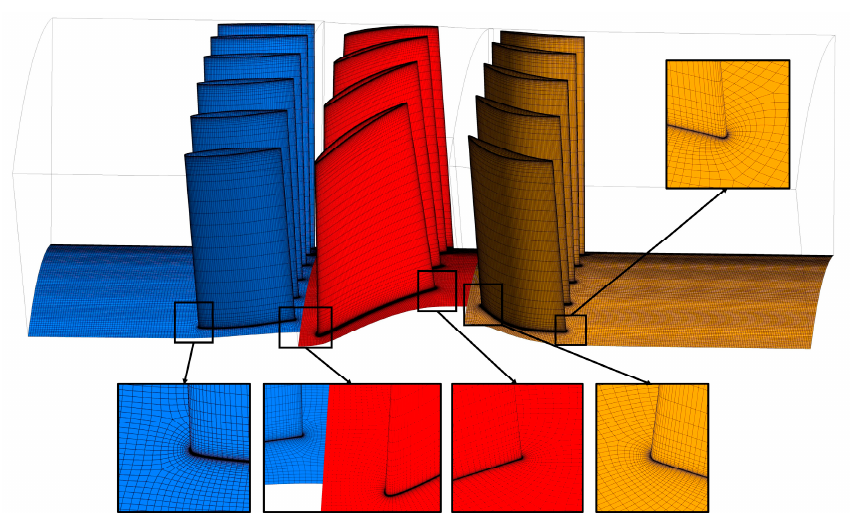
Figure 5. Aerodynamic analysis grids. The blue parts show the guide vanes grids, the red parts show the moving vanes grids, and the yellow parts show the stator vanes grids.